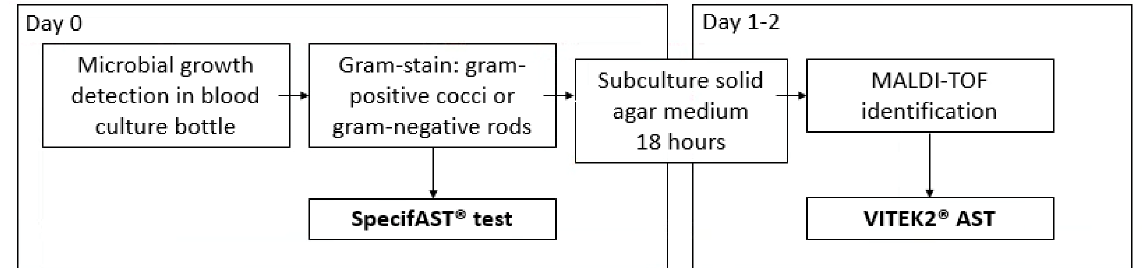
Figure 1. Study procedures MALDI-TOF: matrix-assisted laser desorption-ionization/time-of-flight mass spectrometry.